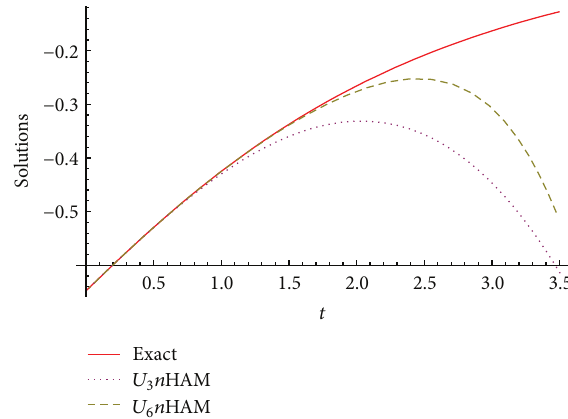
Figure 13: The comparison between the 𝑈 3 , 𝑈 6 of 𝑛 HAM (m 𝑞 - HAM; 𝑛 = 1) , and the exact solution of (40) at ℎ = −1 and 𝑥 = 1 .